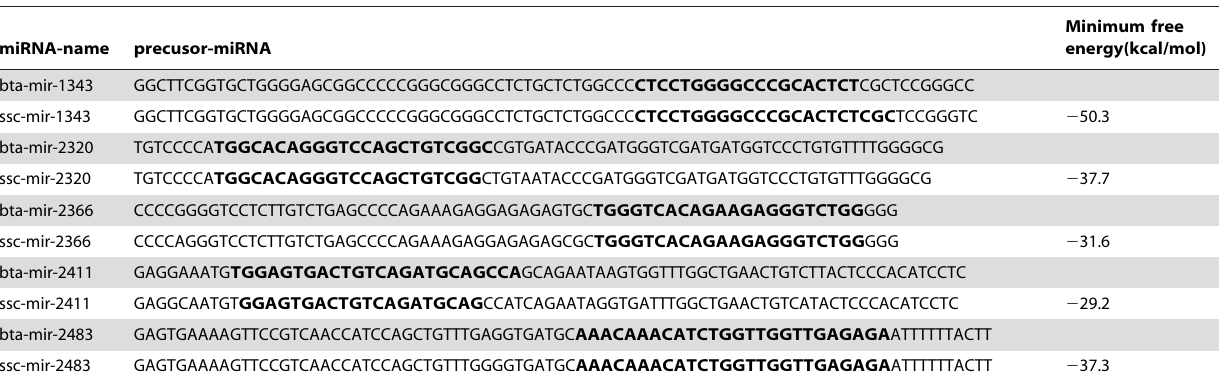
Table 2. Comparison of predicted novel miRNAs in pigs with their homologs in Bos taurus .